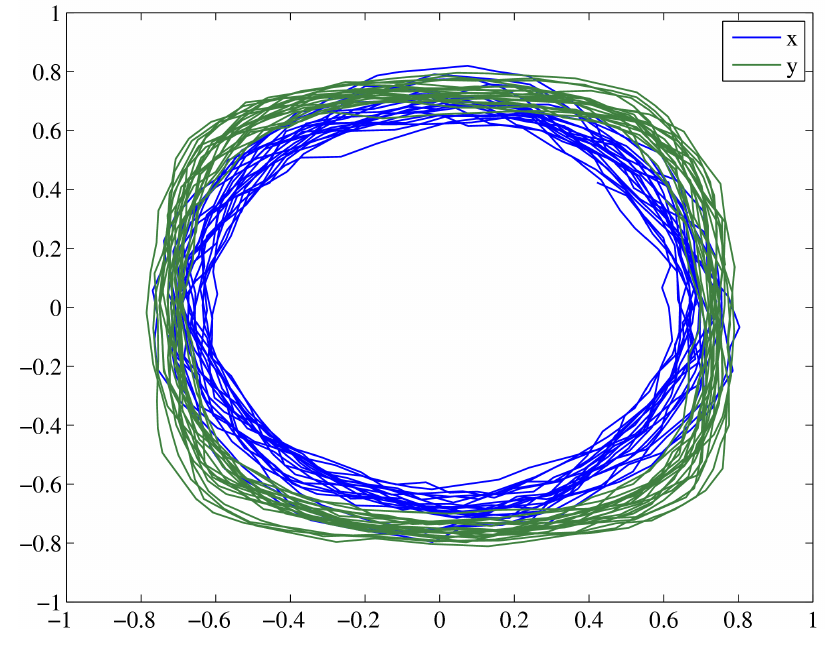
Figure 5. Motor space (blue line) and sensor space (green line) show the temporary stable rotational mode of the skidding snake (1000 time steps